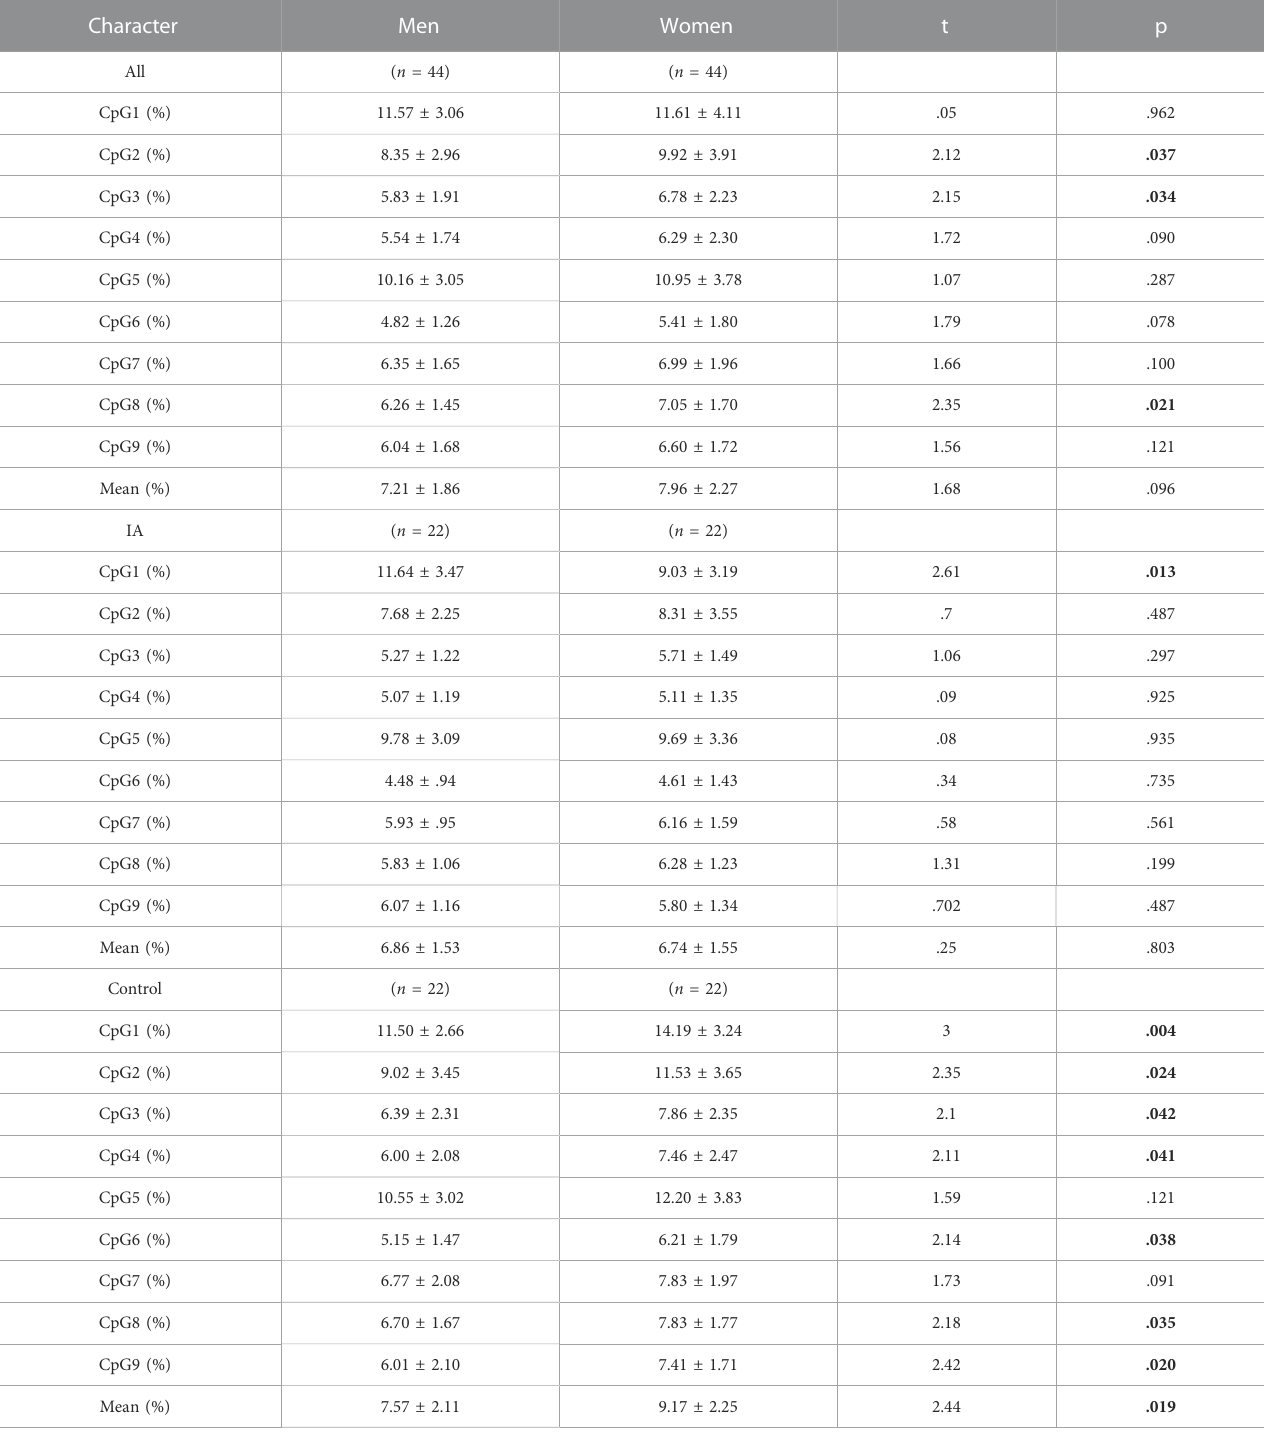
TABLE 5 The gender differences in DNA methylation of nine CpGs of GSTA4 gene in IAs and controls respectively.